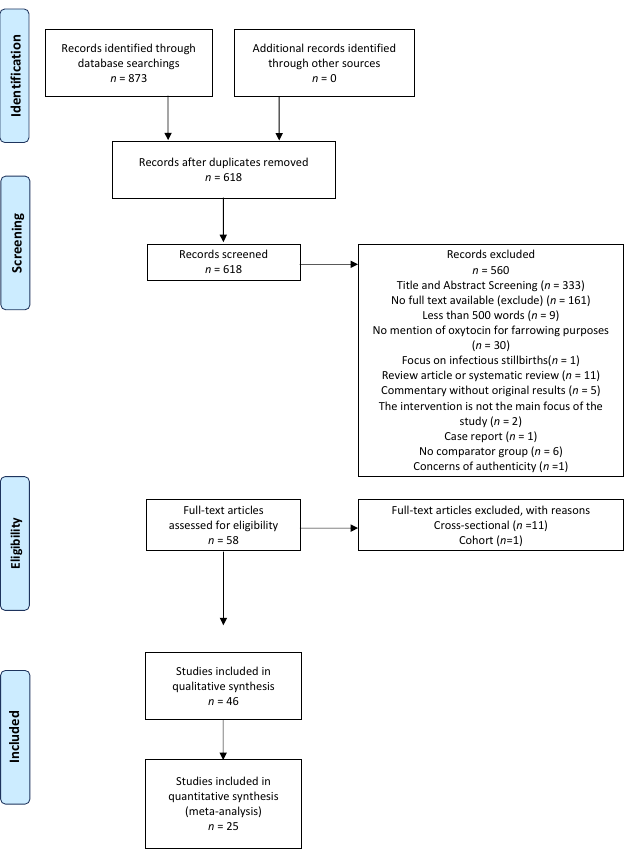
Figure 1. Preferred reporting items for systematic review and meta-Analysis (PRISMA) flow dia- gram.